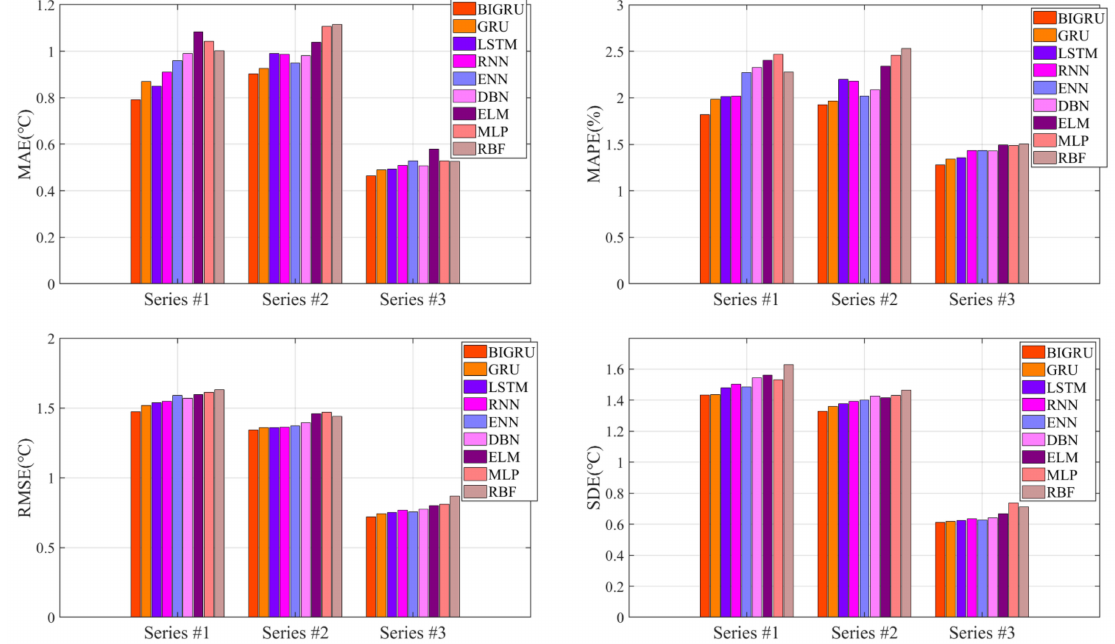
Figure 7. Forecasting performance evaluation indexes: MAE, MAPE, RMSE, and SDE values of different